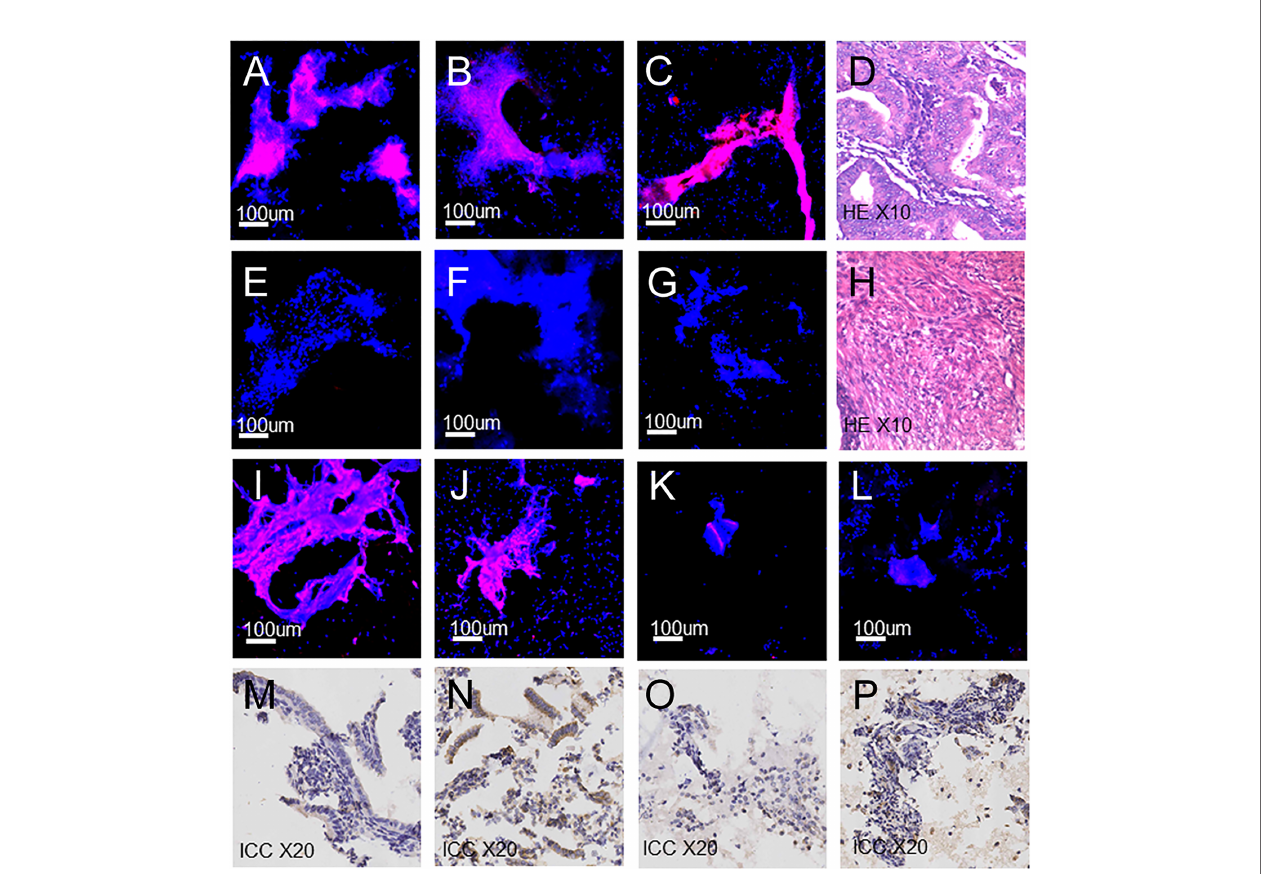
FIGURE 4 | Fluorescence images, H&E and ICC images of endometrial cells. (A – C) Fluorescence images: (A) Endometrial carcinoma. (B) Clear-cell carcinoma. (C) Endometrial atypical hyperplasia. (D) Endometrial carcinoma (H&E). (E – G) Fluorescence images: (E) Proliferative endometrium. (F) Secretory endometrium. (G) Atrophic endometrium. (H) Proliferative endometrium (H&E). (I – K) Fluorescence images of false-positive cases. (L) Fluorescence images of false-negative cases. (M – O) ICC images of false-positive cases: (M) Staining intensity 1, weak. (N) Staining intensity 2, moderate. (O) Staining intensity 0, no staining. (P) ICC images of false-negative cases, staining intensity 1, weak.